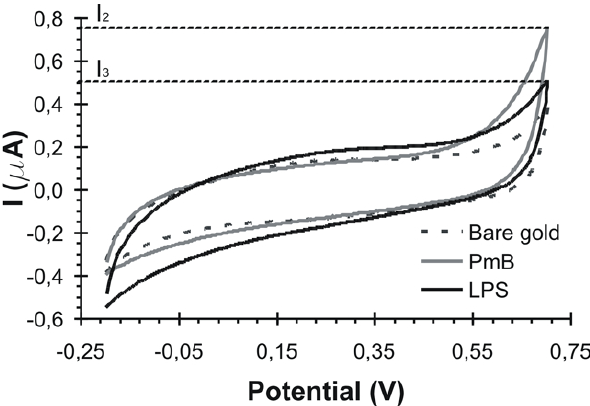
Figure 3. Cyclic voltammogram ( − 0.2–0.7V) of the bare gold, the immobilized PmB (100 µ gmL − 1 ) and the detected LPS (100 µ gmL − 1